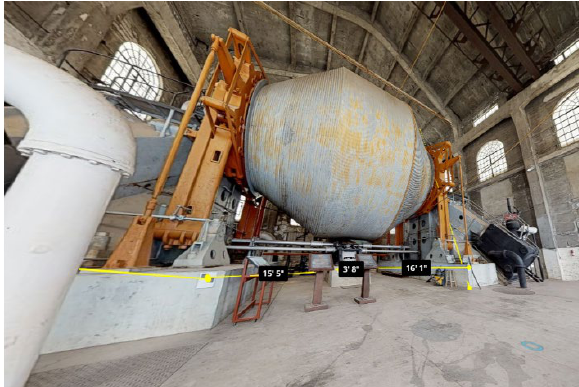
Figure 15. Screenshot from VR tour “from outside to